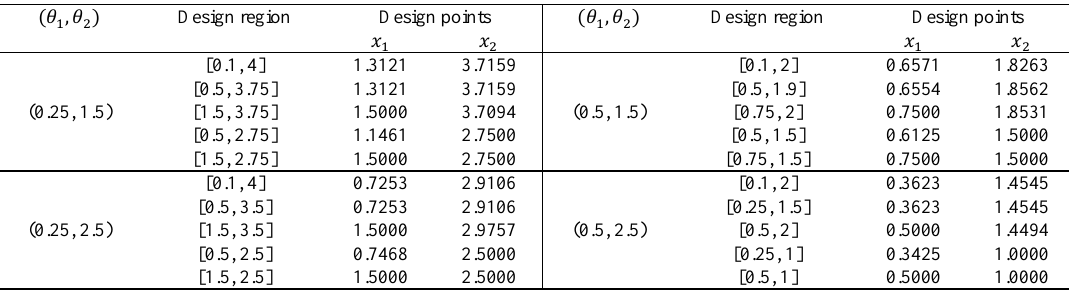
𝑤 = 0.5, 𝑤 = 0.5 1 2